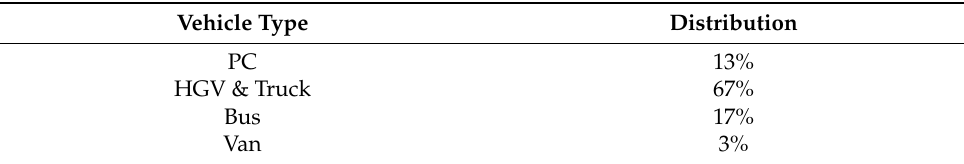
Table 5. Distribution of fire rates based on vehicle type.